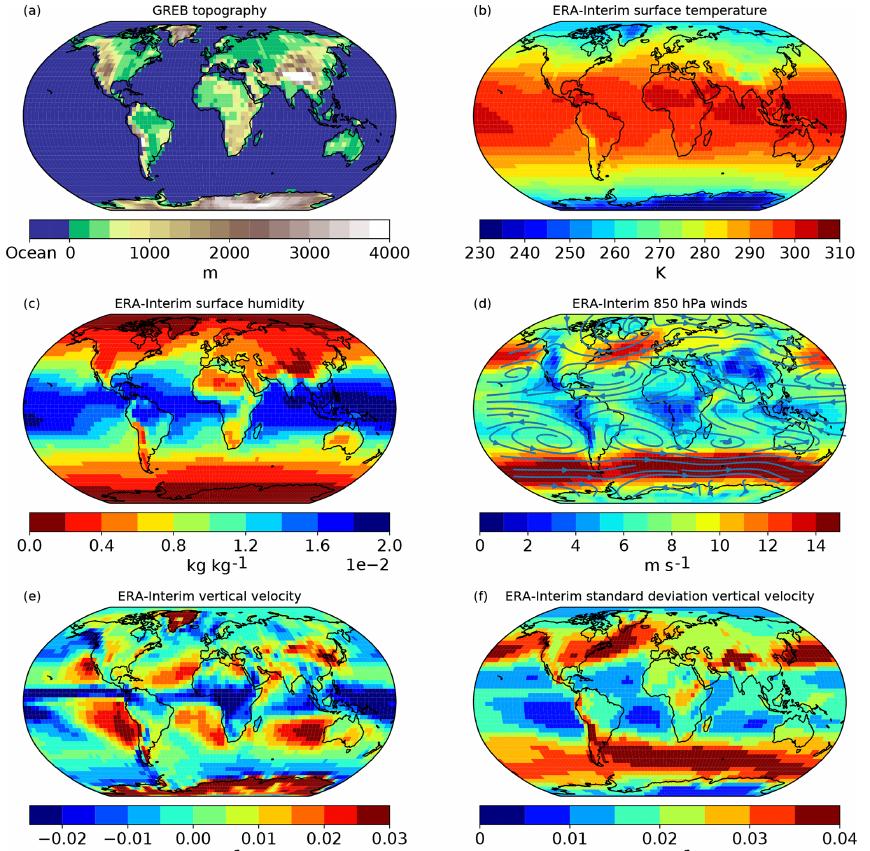
Figure 1. GREB mean state boundary conditions and reference climatologies: topography (a) , surface temperature (b) , surface humidity (c) , 850hPa wind direction (streamline) and strength (shading) (d) , vertical velocity ω (e) and the daily standard deviation of vertical velocity ω (f)